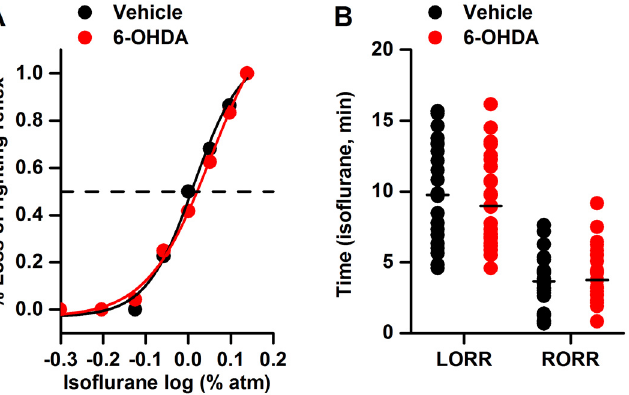
LORR: loss of the righting reflex; RORR: return of the righting reflex. P > 0.05 vs . vehicle; n = 22 for the vehicle group and n = 23 for the 6-OHDA group.